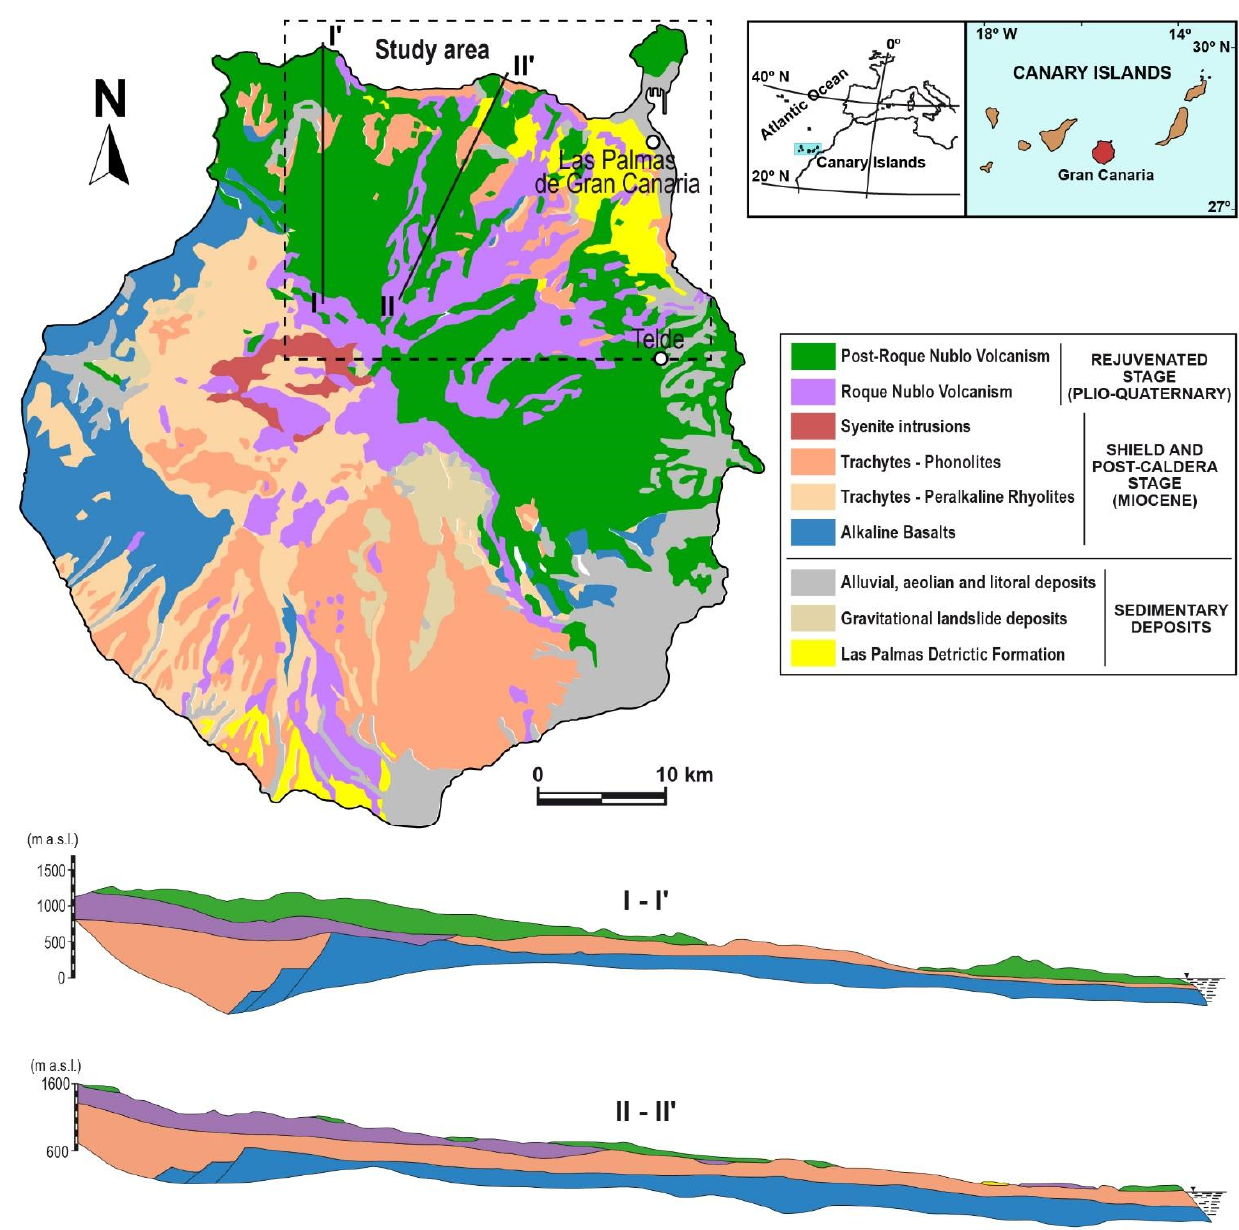
Figure 1. Location of the study area. Simplified geological map of Gran Canaria (modified from [17]) and geological cross sections of the study area. The sections were made using geological data from wells (modified from